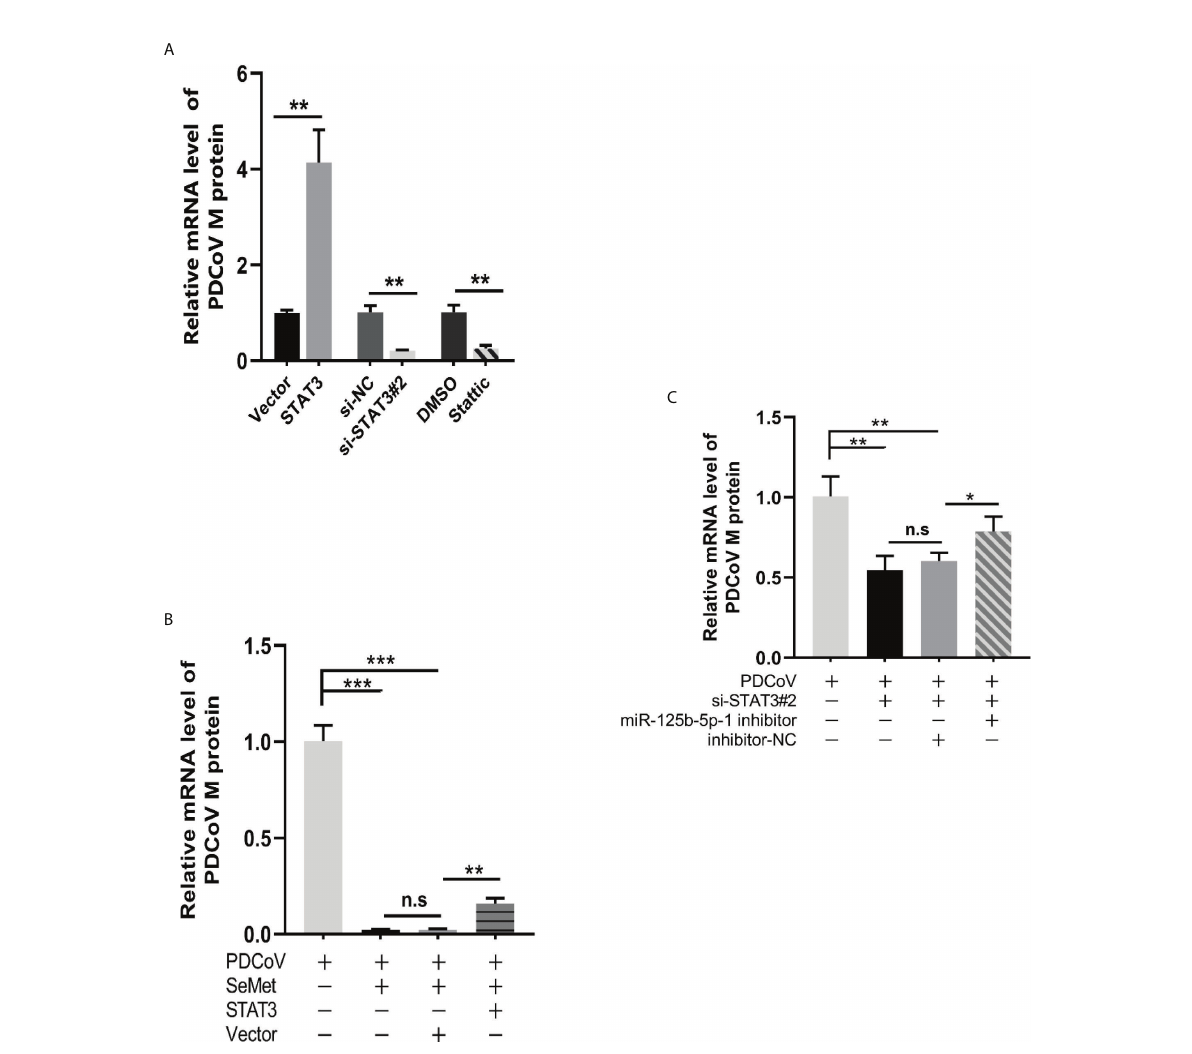
FIGURE 5 Decreased STAT3 levels are utilized by SeMet to suppress PDCoV replication. (A) Expression level of viral mRNAs was analyzed by qRT-PCR when transfected with pcDNA3.1-STAT3, empty vector, siSTAT3, siRNA-NC, DMSO, Stattic (0.75 m M) (n=6). (B) Cells were transfected with pcDNA3.1-vector or pcDNA3.1-STAT3, followed by treatment with SeMet and PDCoV. Viral mRNA expression was analyzed by qRT-PCR (n=6). (C) Expression level of viral mRNAs was analyzed by qRT-PCR when transfected with siSTAT3 and miR-125b-5p-1 inhibitor followed by infection with PDCoV (n=6). Means ± SD are shown. Statistical signi fi ciance was determined by Student t test. ***, P <0.001; **, P <0.01; *, P <0.05; n.s, not signi fi cant. All experiments were repeated at least twice and representative results are